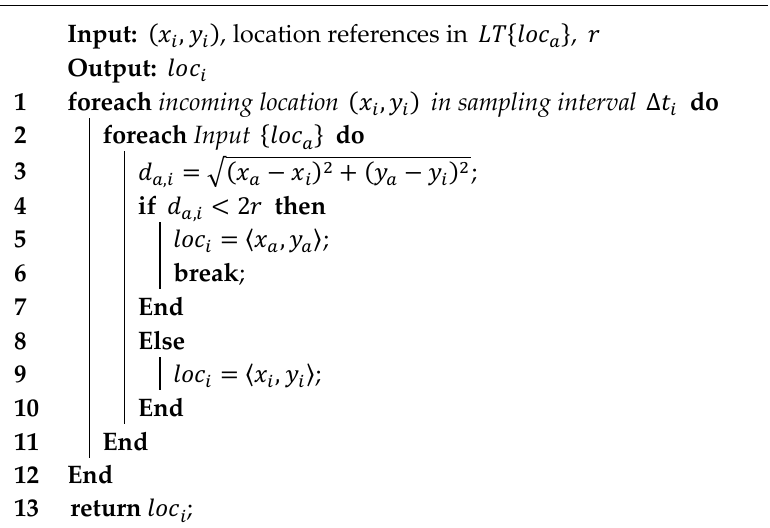
Algorithm 1 The algorithm for recording location information